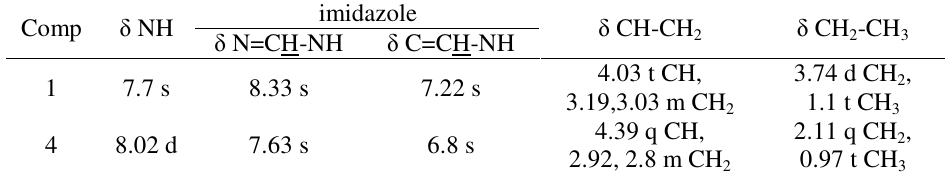
Table 4. Characteristics H 1 NMR of compounds 1 and 4